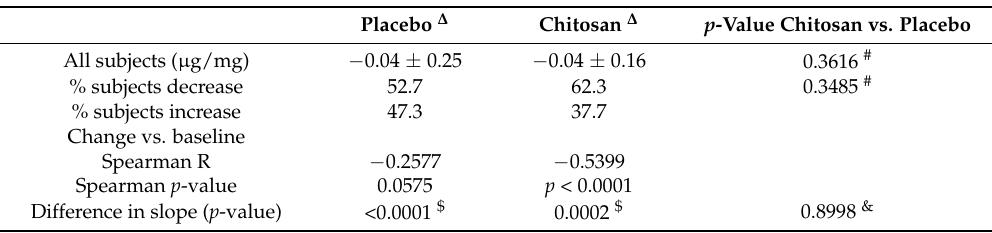
Comparison of changes in serum total R_desmosterol induced by chitosan and placebo treatments.